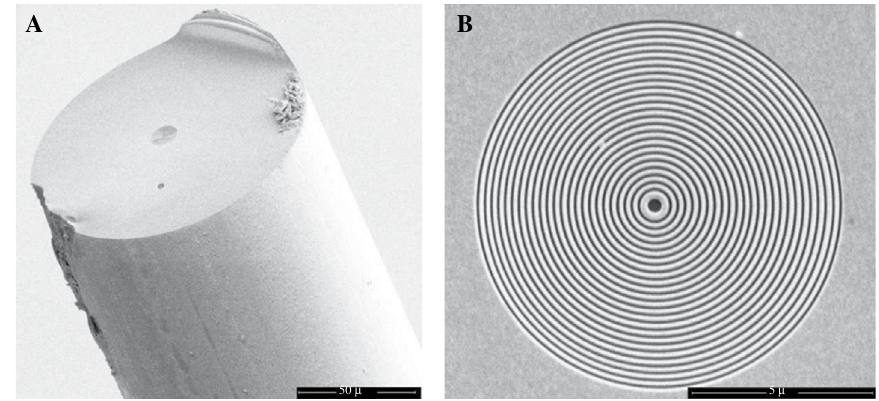
Figure 4 SEM image of (A) 20 periods of concentric metallic rings fabricated onto fiber end and (B) zoom-in of the metallic grating. Adapted from Ref.